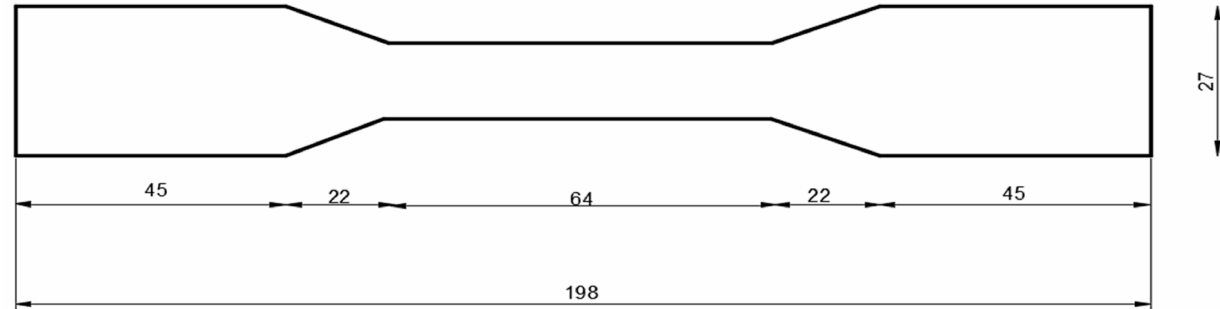
Figure 1. The FRP tensile coupon specimen